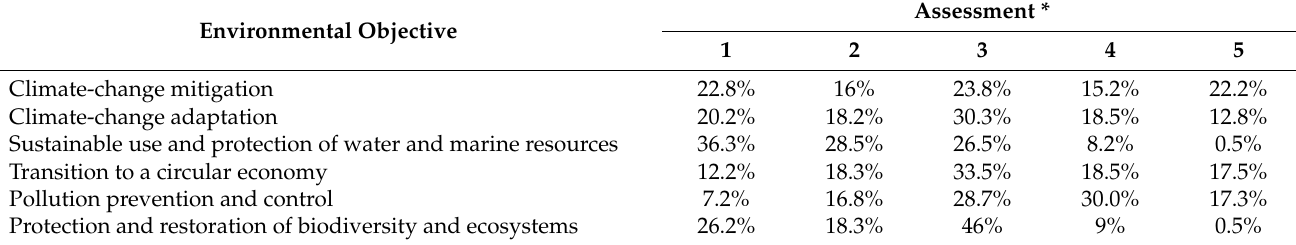
Table 2. Assessment of the degree of conformity of the activities of the enterprises with environmen- tal